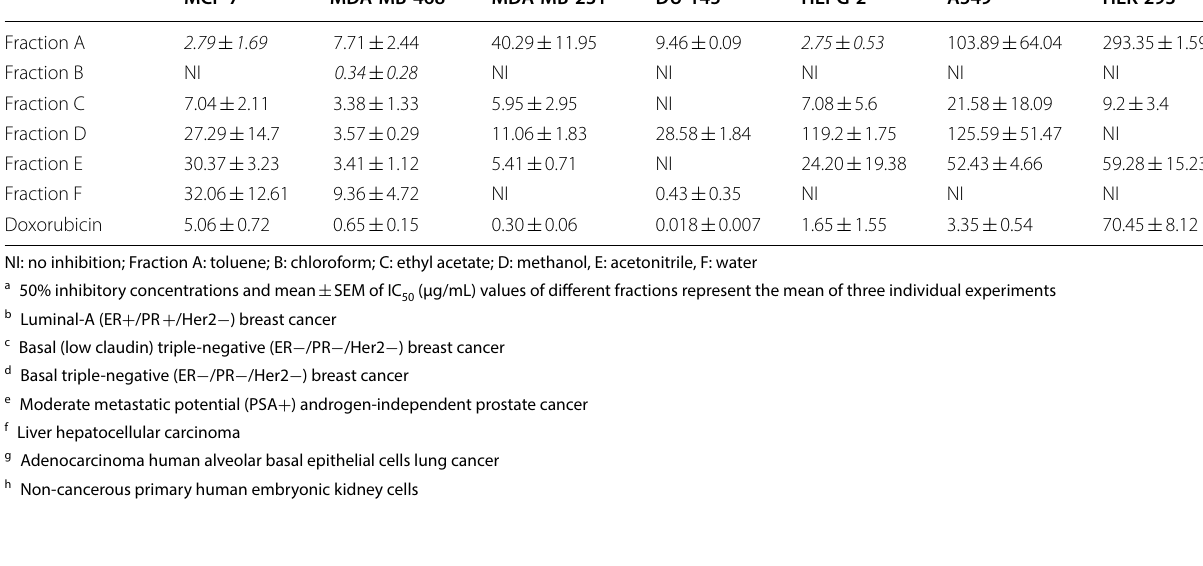
Table 4 Assessment of cytotoxic profile of column chromatography fractions against various tissue-specific cancer